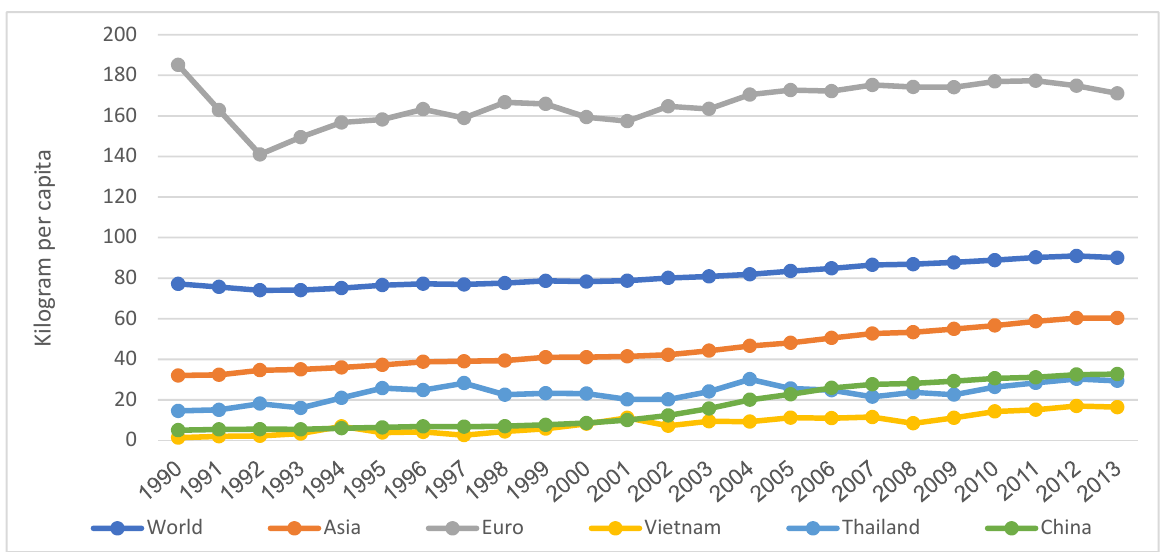
Figure 5. Per capita milk consumption (including milk equivalents of dairy products) (kg). Sources: Authors’ analysis based on FAO [56].